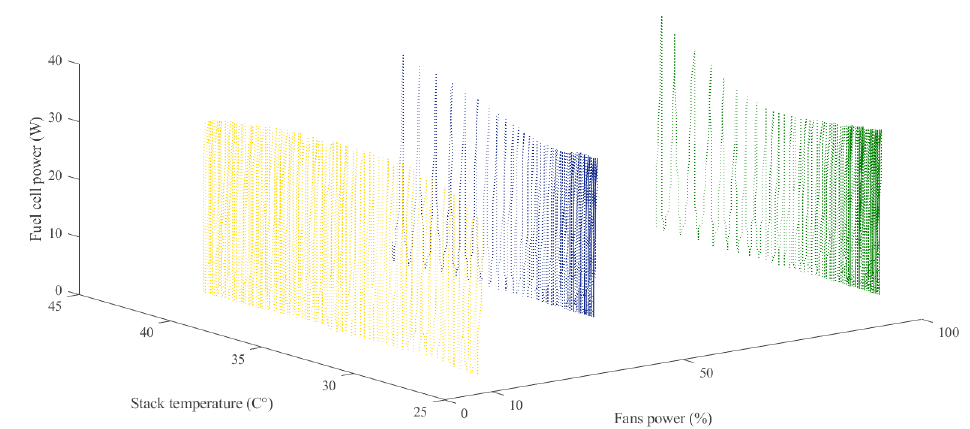
Figure 6. The Heliocentris FC50 stack power according to air flow and stack